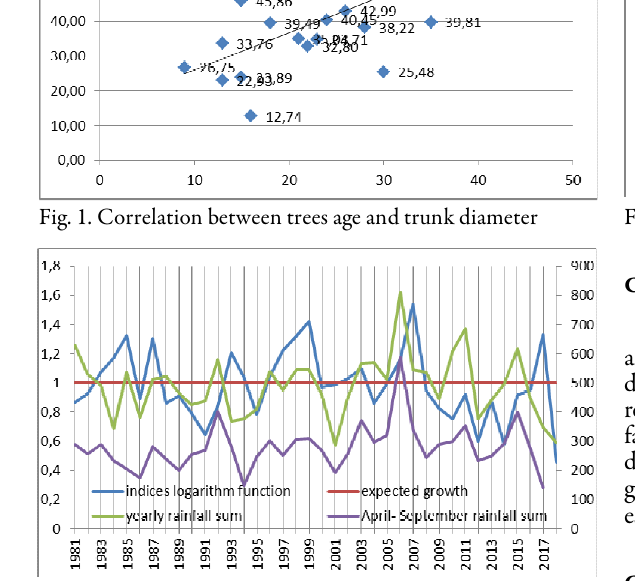
Fig. 3. Correlation coefficients of the radial growth of walnut genotypes under the influence of monthly average rainfall and rainfall over the vegetation